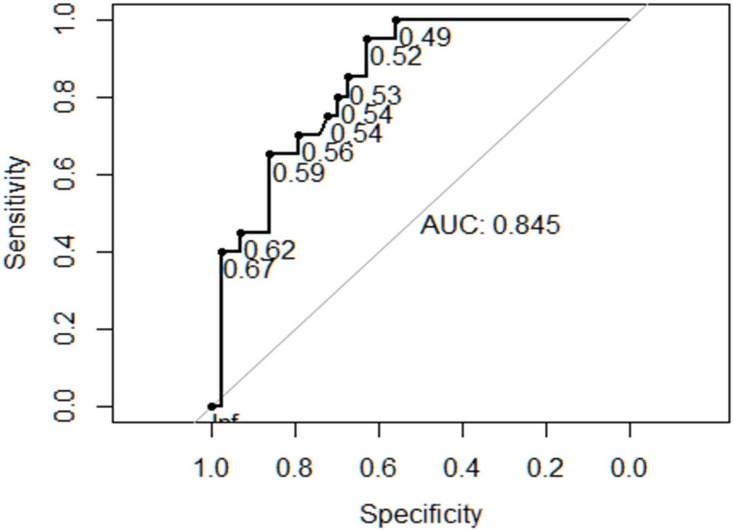
Receiver operator characteristics curve for Mass-to-thorax ratio (MTR) and composite adverse outcome or need for intervention.